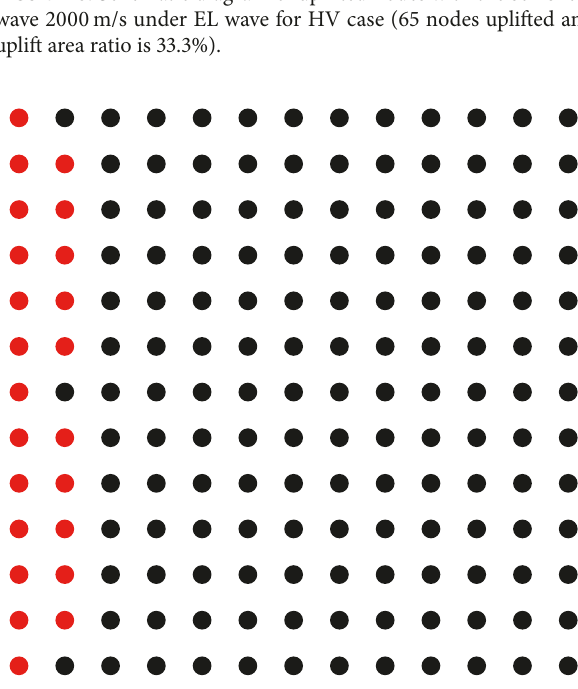
Figure 29: Schematic diagram of uplifted nodes with the soil shear wave 400m/s under El wave for HV case (23 nodes uplifted and uplift area ratio is